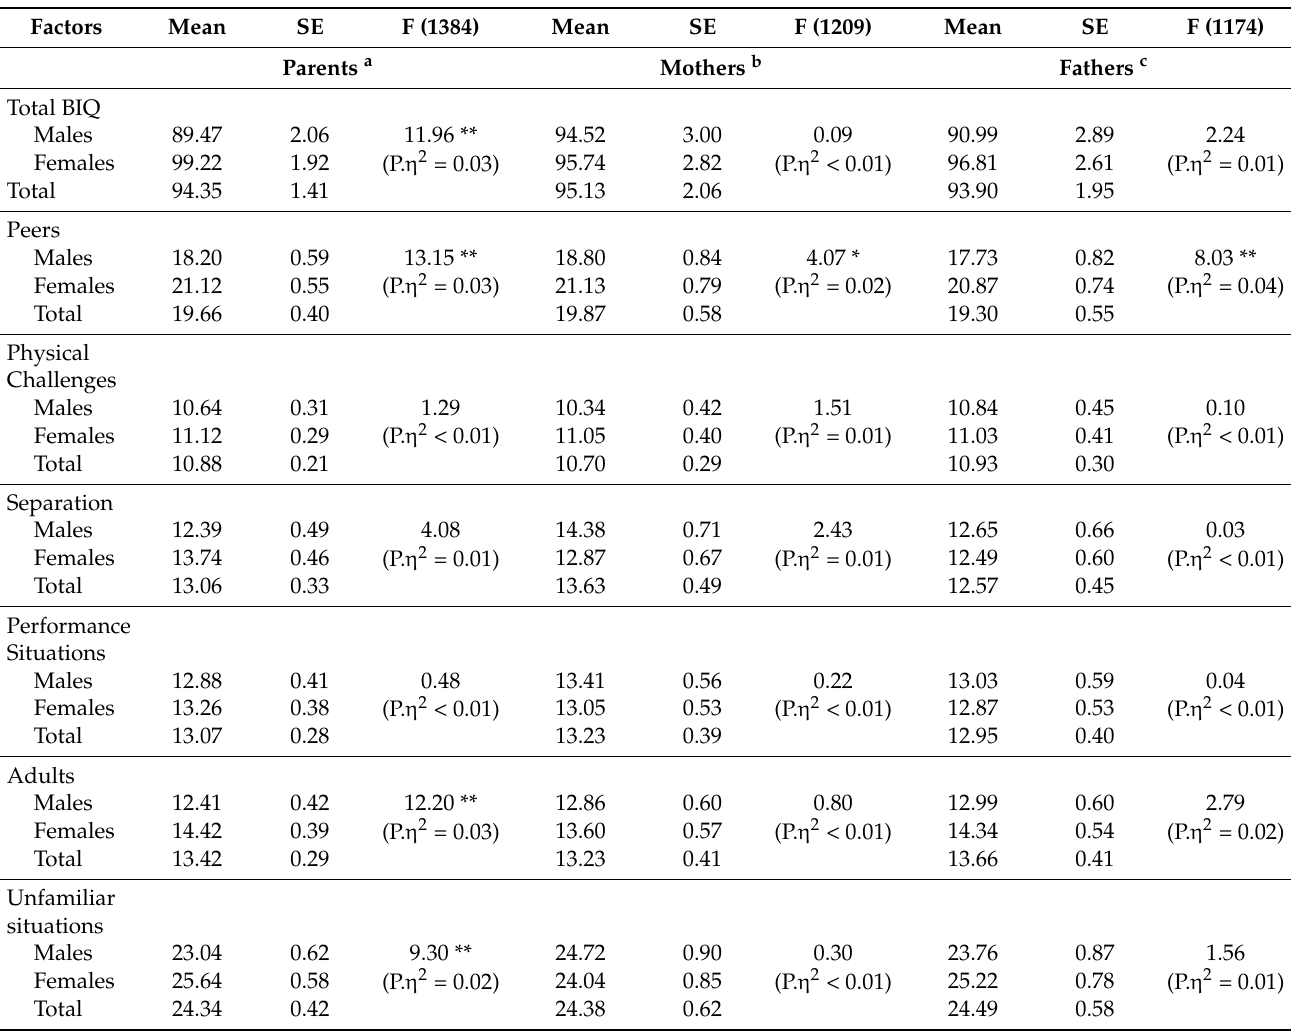
Table 2. Estimated means and standard error (SE) for BIQ subscales and total scores assessed in parents, in mothers and in fathers, evaluating males and